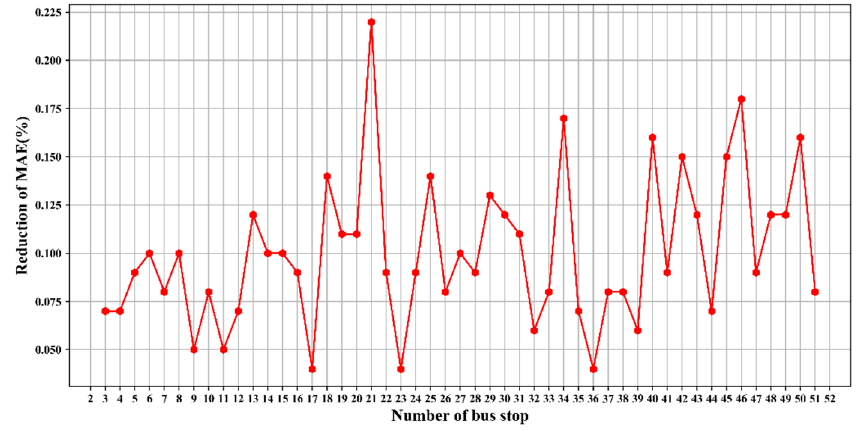
Figure 12. Reduction of MAE compared to DT for different bus stops.